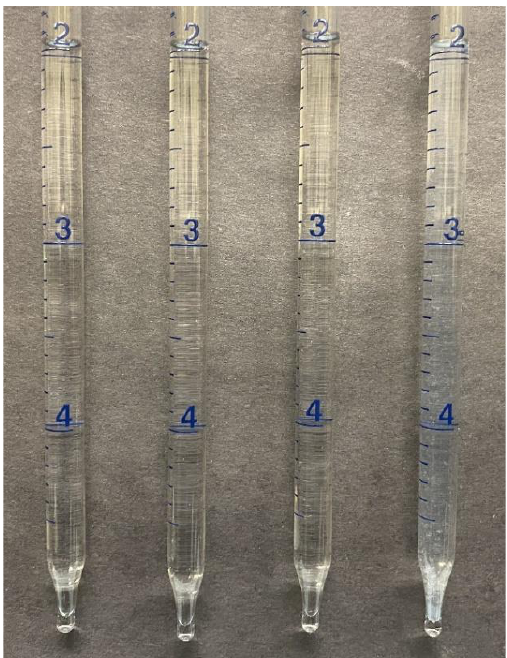
Figure 2. Aqueous stability tests of APG solutions at 45,000 ( Left ), 85,000, 144,000, and 180,000 ppm ( Right ). Pipette graduations shown are in mL.